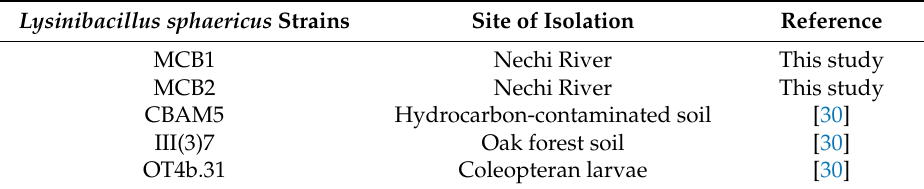
Table 1. Strains evaluated in the bioassays of this